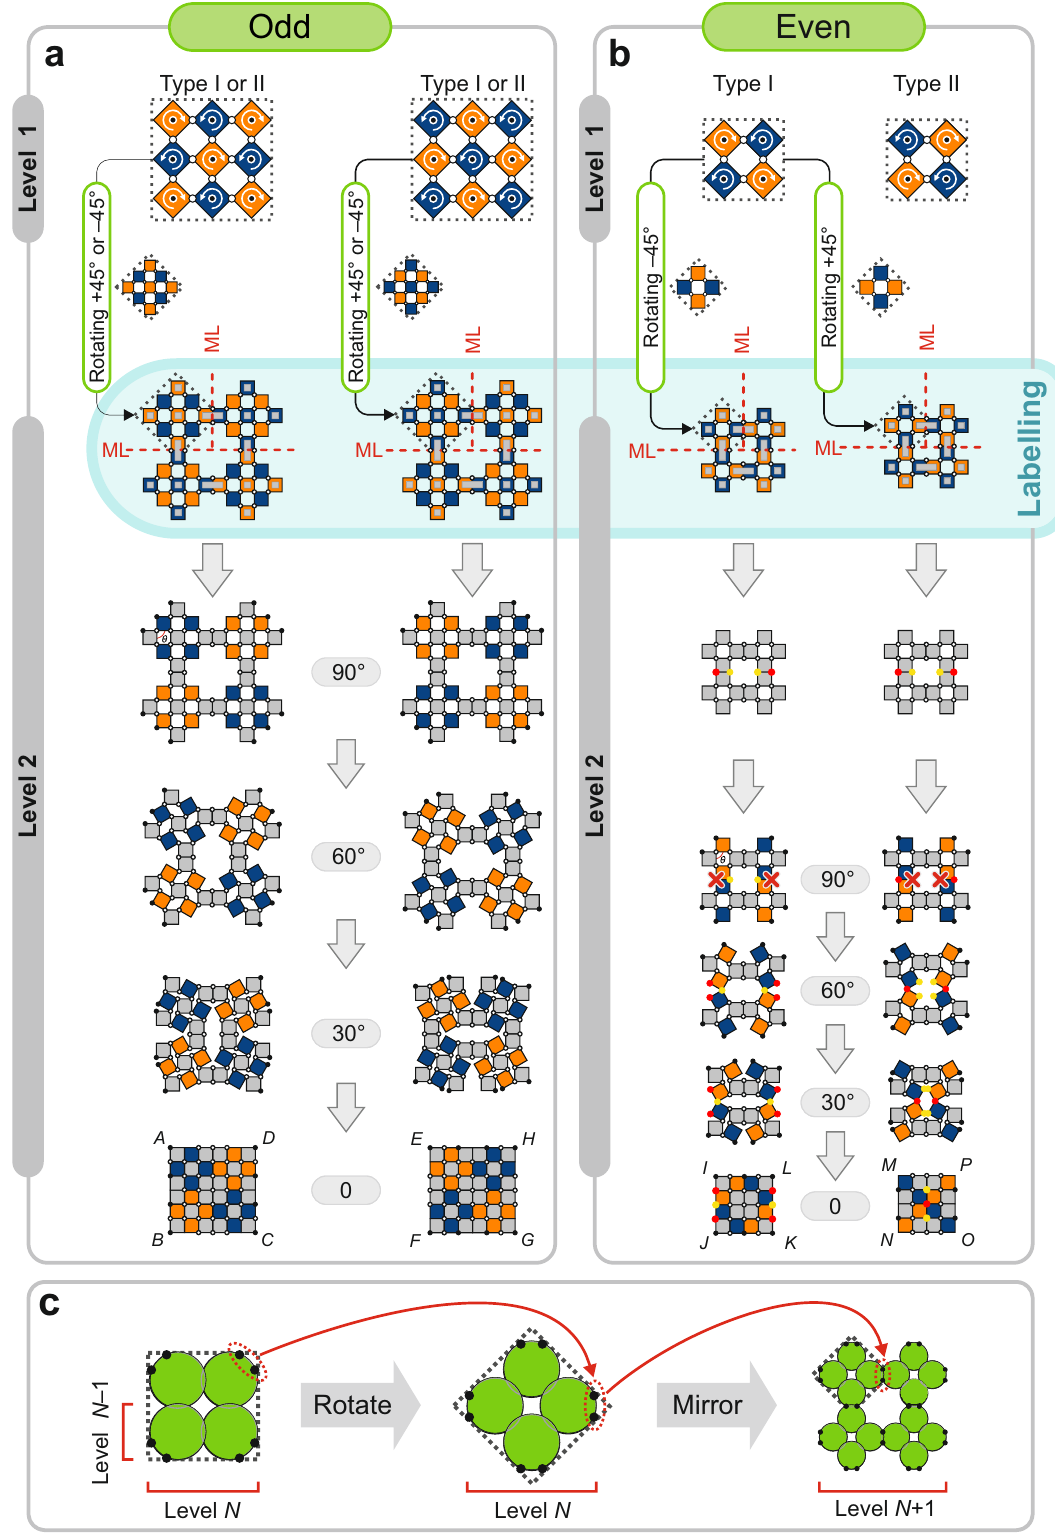
Fig. 1 Generating hierarchical levels using the method of rotate-and-mirror (RAM) and simulating the motion of each element. This diagram demonstrates how we generate the hierarchical level of Type I or/and Type II with a odd, and b even numbers of square elements. After generating each assembly, rotationally-neutral elements are labelled as grey elements. By removing a pair of red or yellow hinges, it is possible to contract the even- numbered assembly (ENA) of level 2. The red cross shows which pair of hinges should be removed in each ENA. c Schematic representation of the connecting hinges, represented by black circles, that facilitate the generation of the assembly of the next level of the hierarchy from the sub-assemblies represented by green